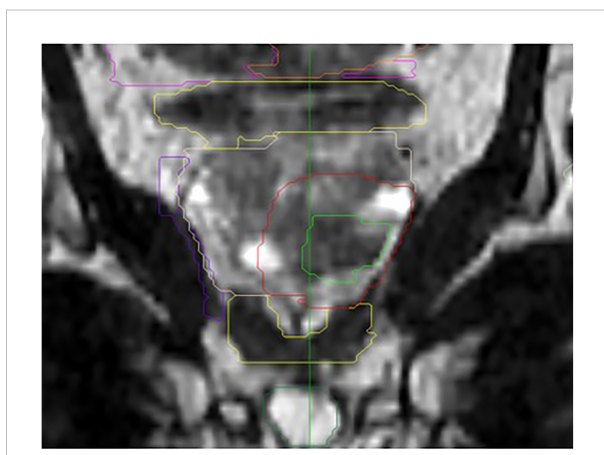
FIGURE 1 Example of delineated focused stereotactic treatment on the MRI T2 sequence frontal view. Purple = contralateral neurovascular bundle. Lower yellow structure = external sphincter. Light green = gross target volume. Red = clinical target volume. Dark green = penile bulb.